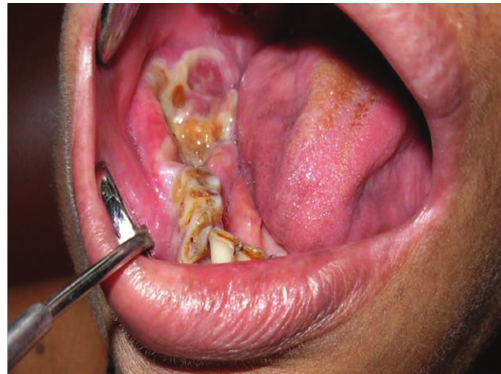
Figure 2: Ulceroproliferative growth seen on lower right posterior third molar area.